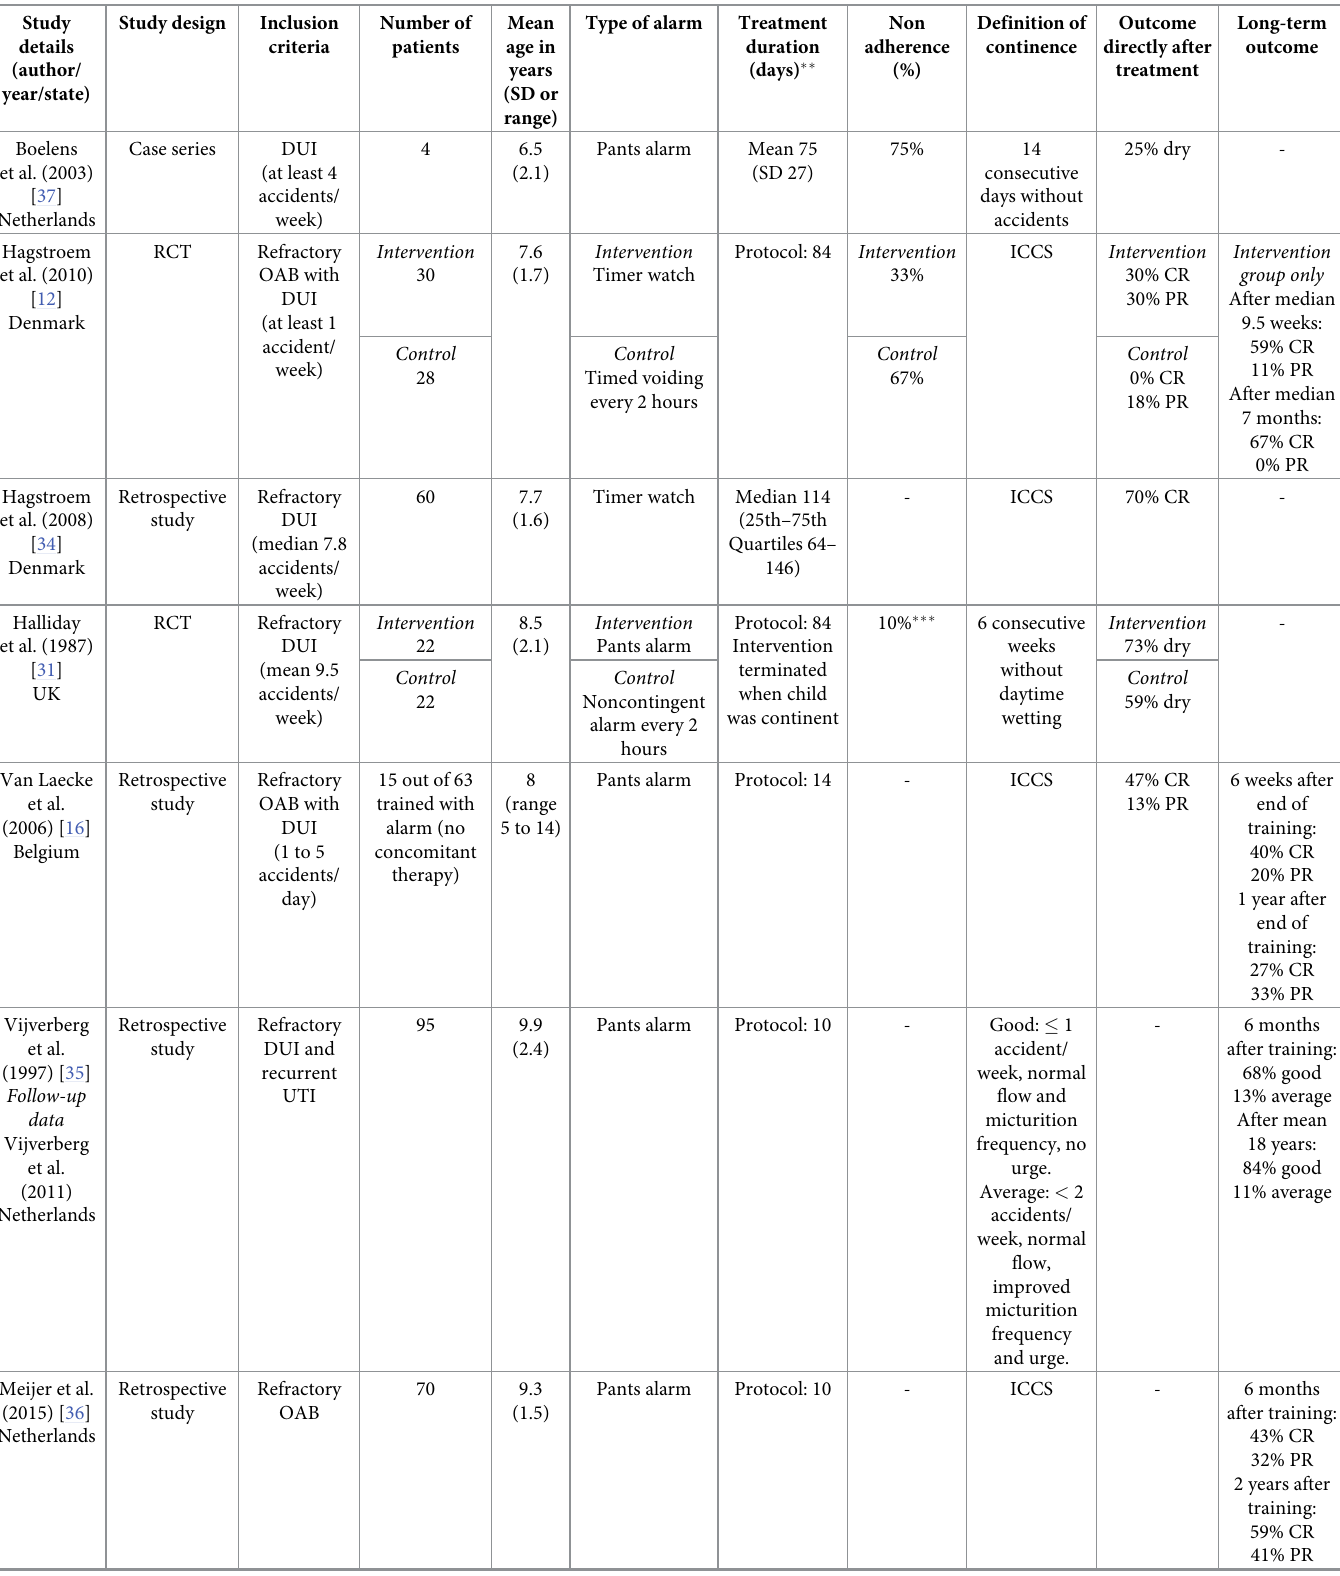
Table 1. Study characteristics of all studies included in this systematic